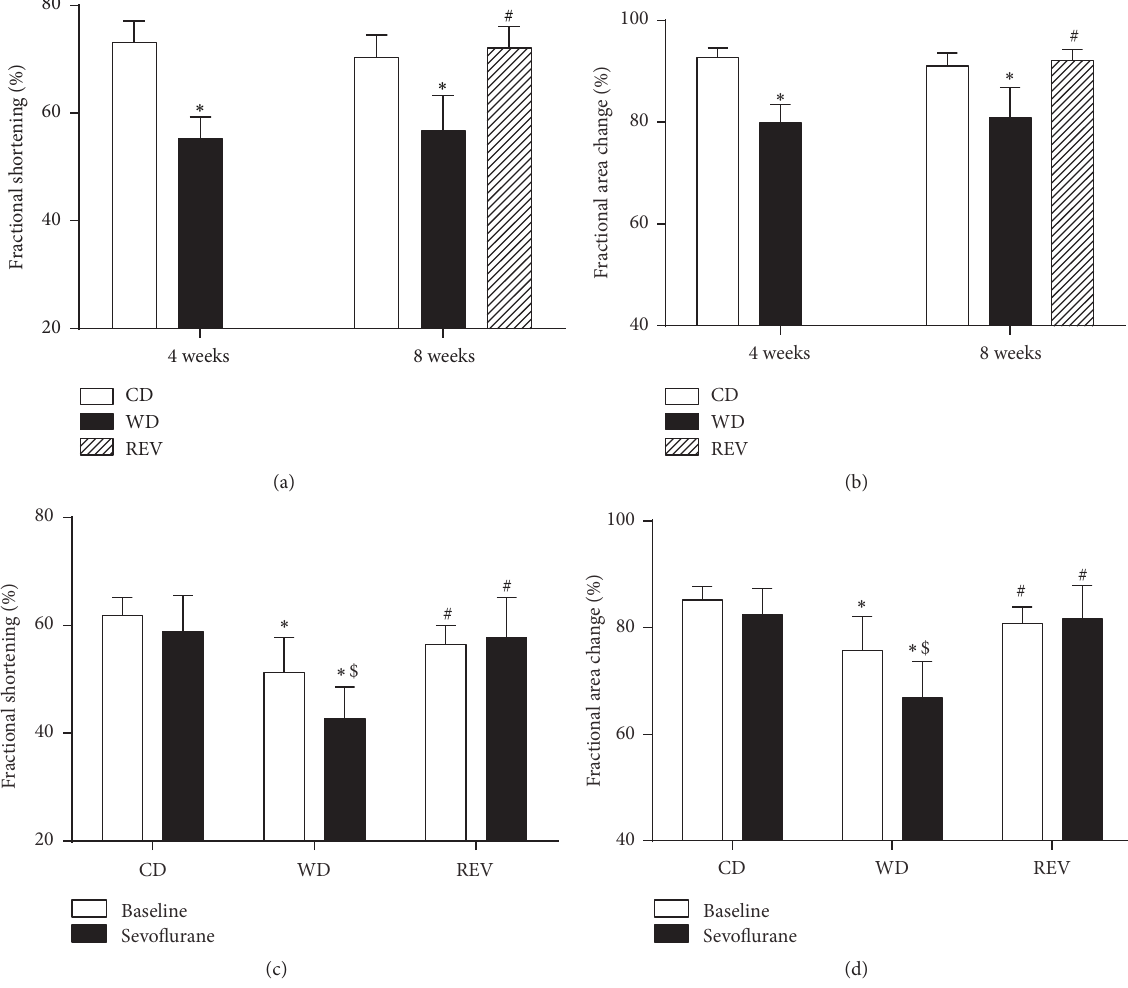
Figure 3: Systolic function after diet feeding with and without sevoflurane exposure. Fractional shortening (a) and fractional area change (b) in rats after 4 and 8 weeks of control diet (CD), western diet (WD), or diet reversion (REV) feeding. Fractional shortening (c) and fractional area change (d) during baseline and sevoflurane exposure in rats after 8 weeks of control diet (CD), western diet (WD), or diet reversion (REV) feeding. Data are mean ± SD, 𝑛 = 6 , two-way ANOVA with Bonferroni post hoc analyses, ∗ 𝑝 < 0.05 versus CD, # 𝑝 < 0.05 versus WD, and $ 𝑝 < 0.05 versus